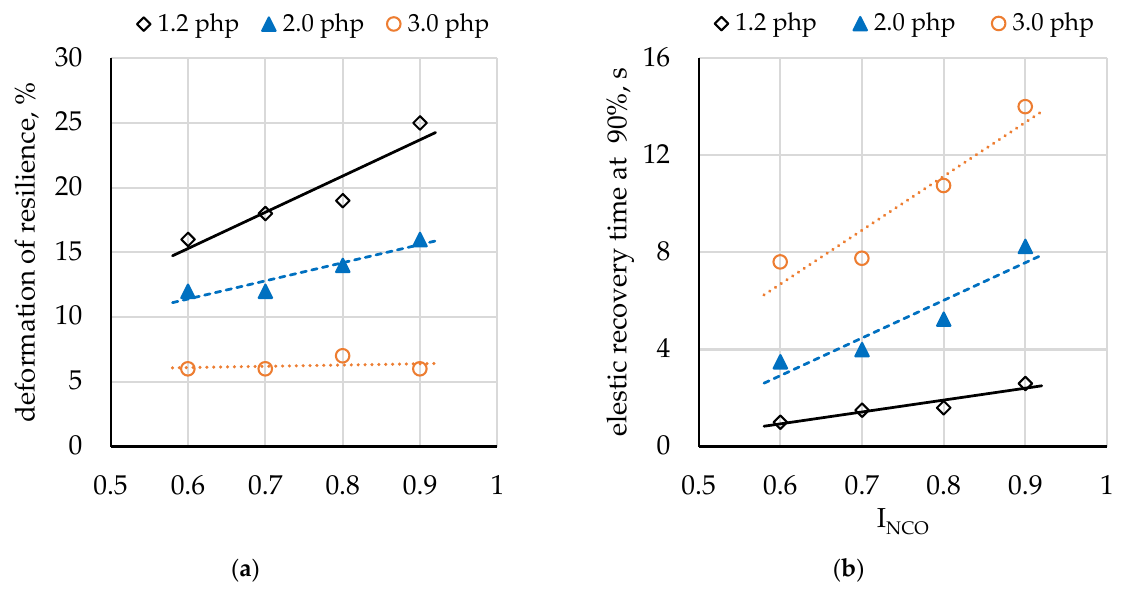
Figure 7. Comparison of ( a ) rebound resilience and ( b ) elastic recovery time for different I NCO and water content levels.